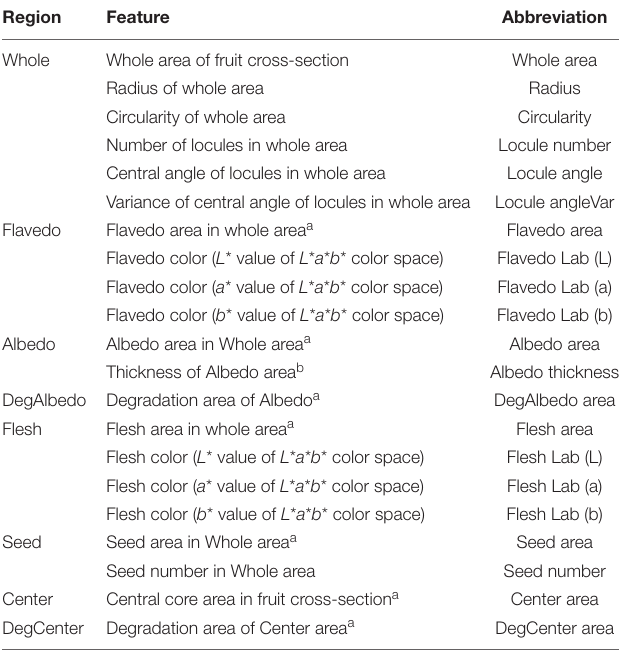
TABLE 1 | Fruit morphological features evaluated in this